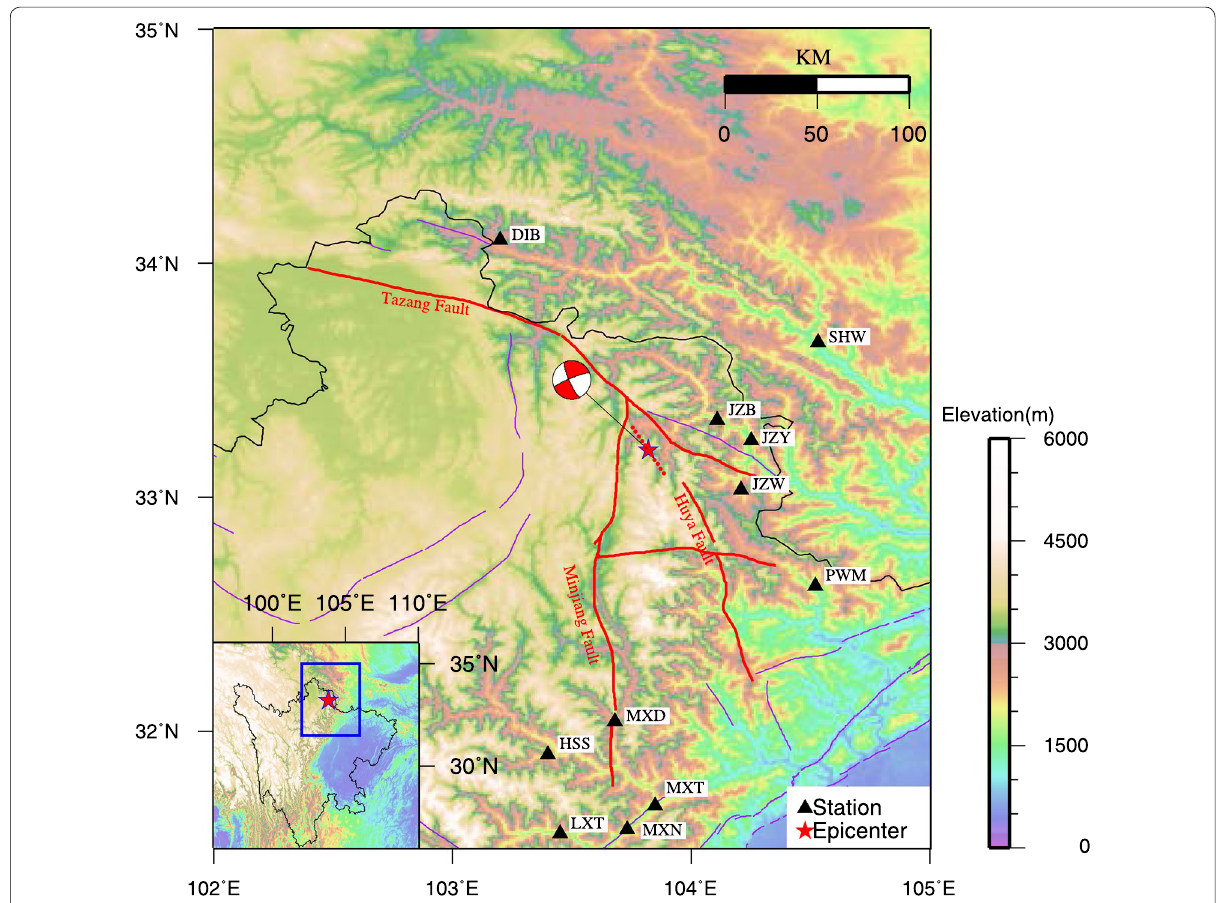
Fig. 1 Map showing the tectonic setting of the Jiuzhaigou area. Red stars indicated the epicenter of the Ms 7.0 Jiuzhaigou earthquake. The Minjiang, Tazang and Huya active faults are indicated by red lines. Beach ball diagrams are from CENC. Black triangles denote the locations of ground-motion stations. The details of ground-motion stations are listed in Table 1. The inset shows the location of the current working